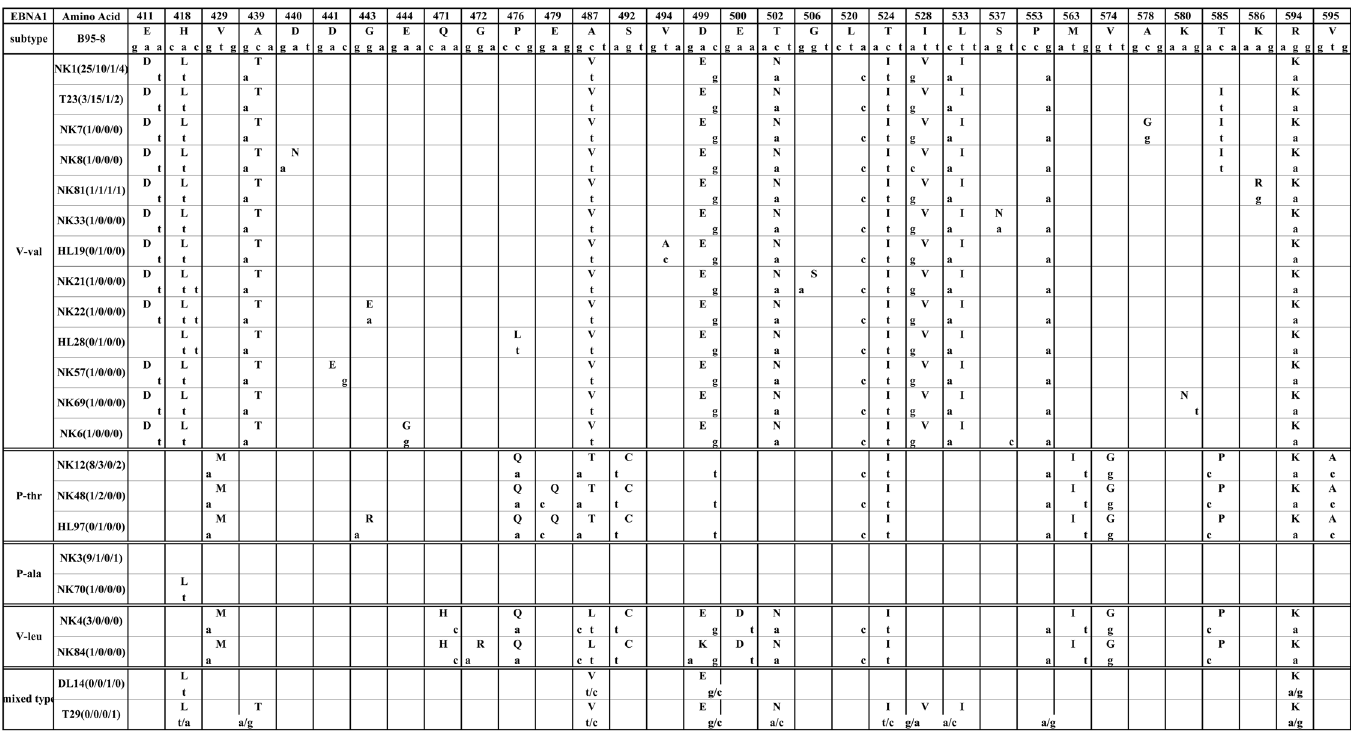
Fig 1. EBNA1 sequence variations in four groups of lymphoma. The numbers across the top correspond to the amino acid positions under which the B95-8 prototype amino acid and nucleotide sequence are listed. Different patterns are noted to the left column, while the specimens showing identical sequences to each other are listed by a representative isolate in the second column. The followed numbers in the parentheses denote the amount of the identical sequences from NK/T, HL, DLBCL, and T cell lymphoma, respectively. The small letters denote the nucleotide, and the amino acids are denoted by capital letters. NK: nasal natural killer/T cell lymphoma; HL: Hodgkin ’ s lymphoma; DL: diffuse large B cell lymphoma; T: T cell lymphoma. Some rare sporadic mutations are not shown in Fig